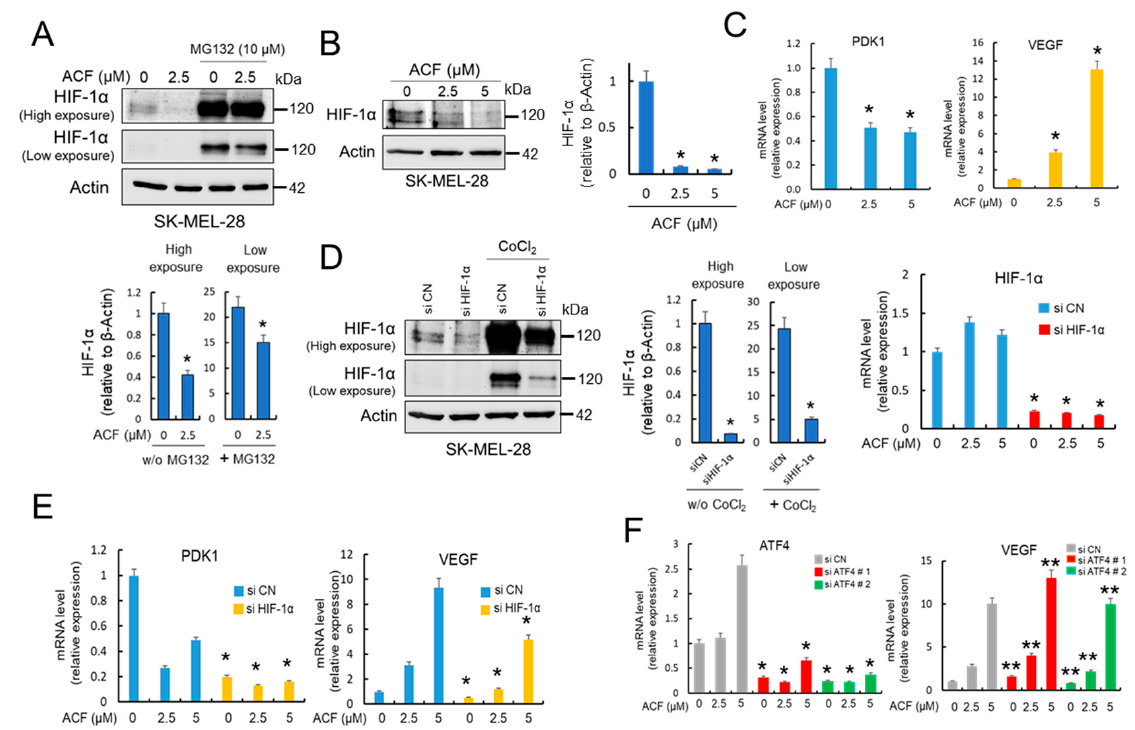
Figure 2. ACF differentially modulates PDK1 and VEGF transcription in melanoma cells. ( A ) Western blot experiments for the effect of ACF on HIF-1 α expression in the absence or the presence of MG132. SK-MEL-28 cells were treated for 12 h with ACF alone or simultaneously co-treated with ACF and MG132. High and low exposure make reference to the exposure time during development of the chemiluminescent signal. HIF-1 α expression in the absence of MG132 (w/o MG132) was quantified on high exposure membranes, while that of HIF-1 α expression in the presence of MG132 was evaluated on low exposure membranes to avoid overexposure (histograms). In both cases, relative HIF-1 α content in the ACF-treated samples was compared with untreated controls in membranes developed under the respective exposure conditions (* p < 0.05). ( B ) Dose-dependent effect of ACF (24 h) on HIF-1 α and IOD quantification (histogram; * p < 0.05). ( C ) Semiquantitative determination of PDK1 and VEGF mRNAs in SK-MEL-28 cells. Relative levels of mRNA (with respect to β -actin) in ACF-treated samples (24 h) were compared to the expression levels in untreated controls (* p < 0.05). ( D ) Effective silencing of HIF-1 α was determined by both western blot experiments and mRNA determinations in SK-MEL-28 melanoma cells. To visualize the silencing of HIF-1 α in western blots, the protein was stabilized with CoCl 2 (200 µ M). Images were obtained under high and low exposure as indicated in Figure 2A and quantified in indicated membranes (histograms) in the absence (w/o CoCl 2 ) or the presence of CoCl 2 (* p < 0.05). HIF-1 α -mRNA in silenced samples were compared with their respective ACF treatments (24 h) in siControls (siCN) samples and differences were found statistically significant (* p < 0.05). ( E ) Semiquantitative determination of PDK1 and VEGF mRNAs in HIF-1 α -silenced SK-MEL-28 cells. HIF-1 α -mRNA in silenced samples were compared with their respective treatments in siCN samples (* p < 0.05). Although VEGF-mRNA decrease in siHIF-1 α cells was found to be statistically significant with respect to siCNs, silencing of HIF-1 α did not completely abolish ACF-dependent induction of VEGF. Cells were treated with ACF for 24 h. ( F ) Effective silencing of ATF4 with two different siRNAs (left panel) did not influence VEGF-mRNA expression in SK-MEL-28 cells. * p < 0.05 and ** not significant when compared with siATF4 samples with their respective treatments in siCN samples. When indicated, cells were treated with ACF for 24 h.